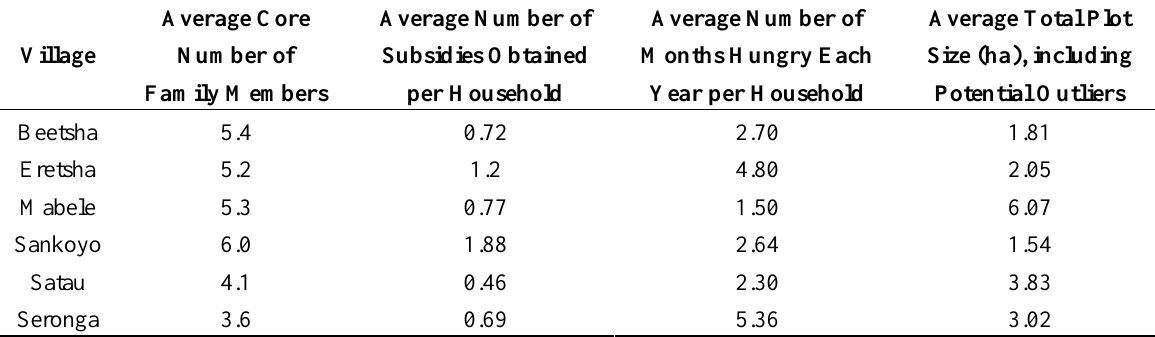
Table 2. Basic household level statistics derived per village based on semi-structured interviews. Average number of core family members represents the average number of people living at least six months a year in the household. Average number of subsidies represents average number of government supplied support programs utilized by the